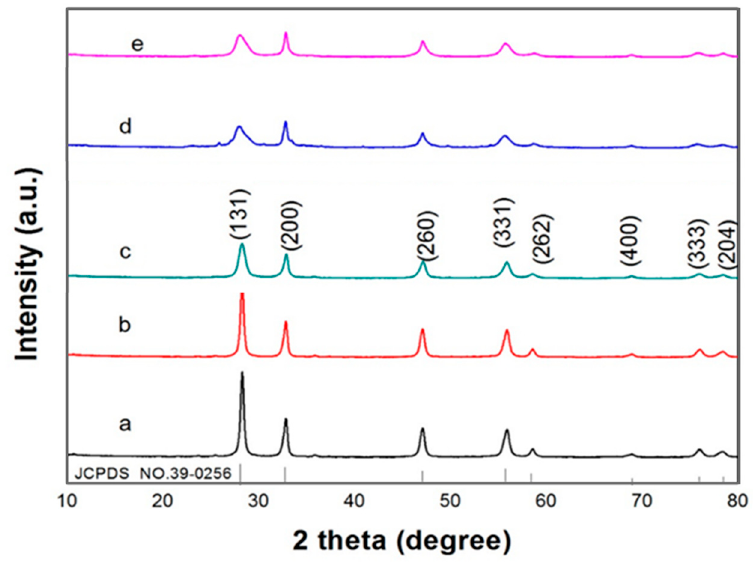
Figure 4. XRD patterns of the samples: ( a ) Bi 2 WO 6 , ( b ) Ti-Bi 2 WO 6 , ( c ) 0.1Ni/Ti-Bi 2 WO 6 , ( d ) 0.4Ni/Ti-Bi 2 WO 6 , and ( e ) 0.7Ni/Ti-Bi 2 WO 6 .